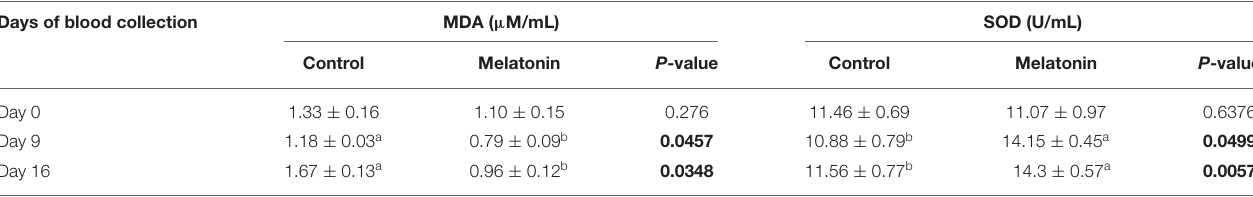
TABLE 2 | Effect of melatonin treatment with MDA and SOD under heat stress condition in Thai-Holstein crossbred cows. Days of blood collection